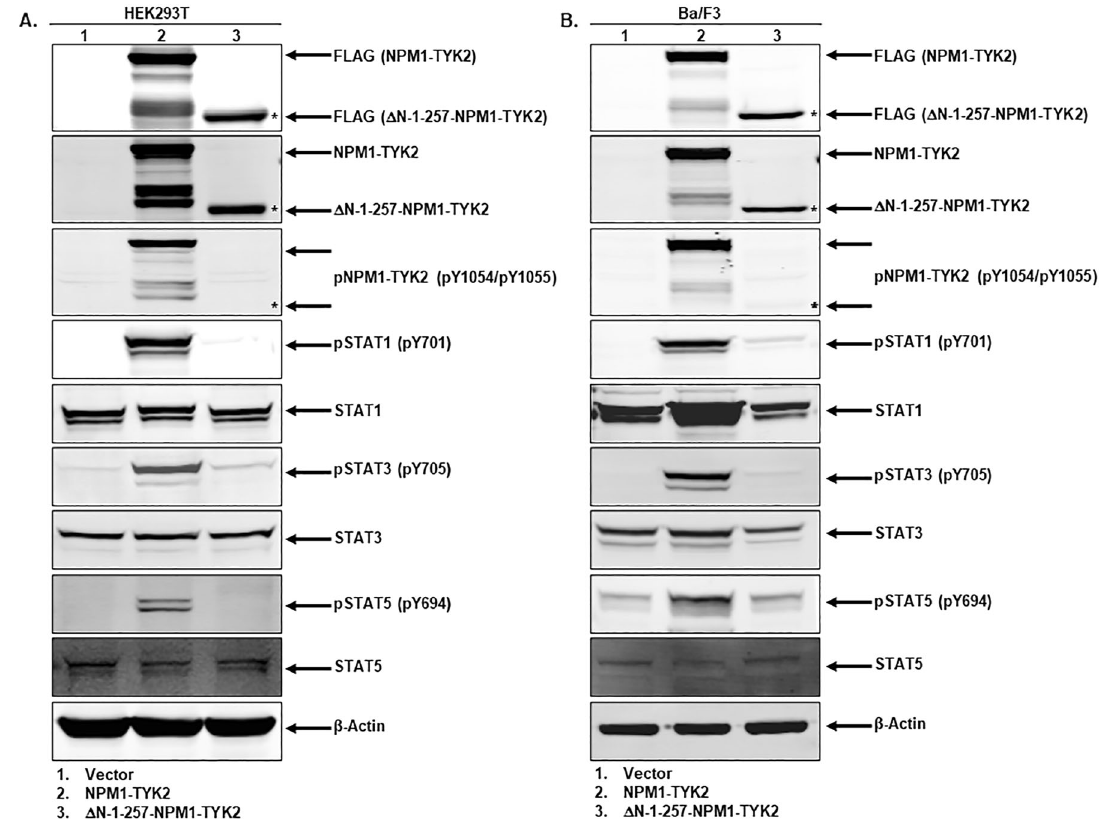
Fig. 7 Fusion partner NPM1 is essential for NPM1 – TYK2 mediated oncogenic signaling. A , B Deletion of NPM1 partner in NPM1 – TYK2 fusion gene inhibits activation of fusion kinase NPM1 – TYK2 mediated signaling in HEK293T and Ba/F3 cells. Western blot analysis of NPM1 – TYK2 (FLAG), phospho-NPM1 – TYK2, phospho-STAT1/3/5, and respective total proteins. β -Actin served as an internal